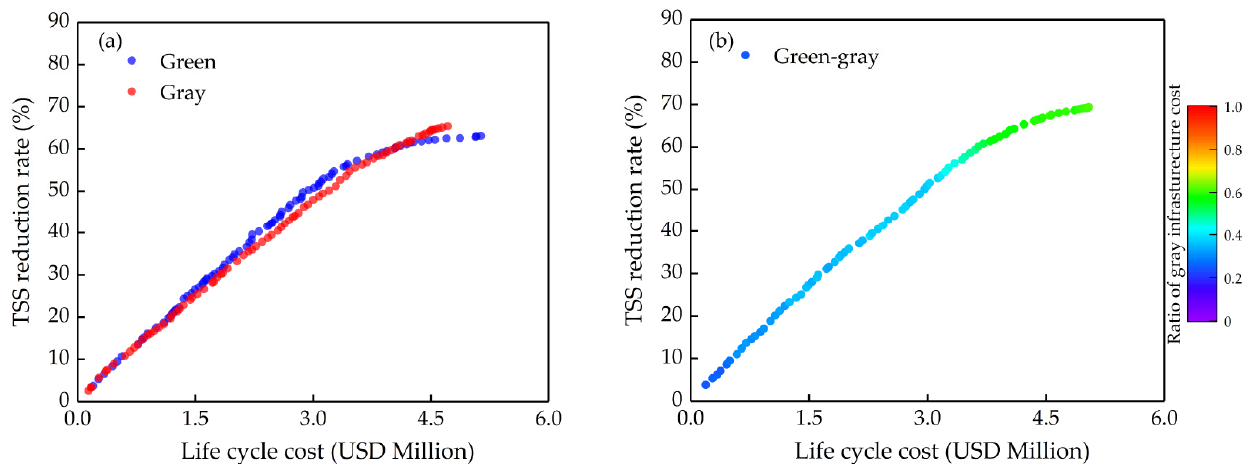
Figure 7. Optimization results when the α coefficient is 3: ( a ) Separate optimizing (green infrastructure only and gray infrastructure only); ( b ) Synchronous optimizing (green-gray infrastructure).